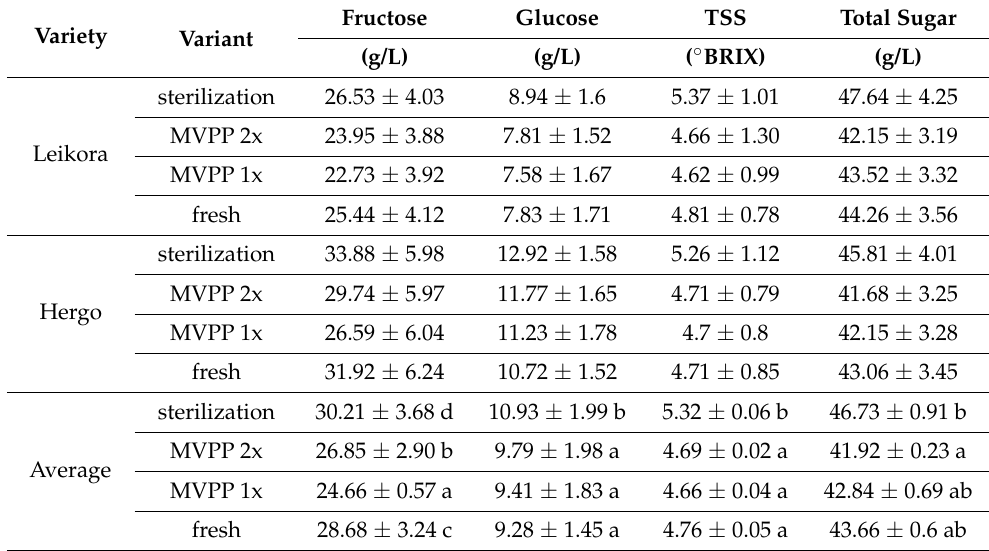
Table 1. Fructose, glucose, TSS, and total sugar content change during thermal treatment variants and their statistical evaluation.